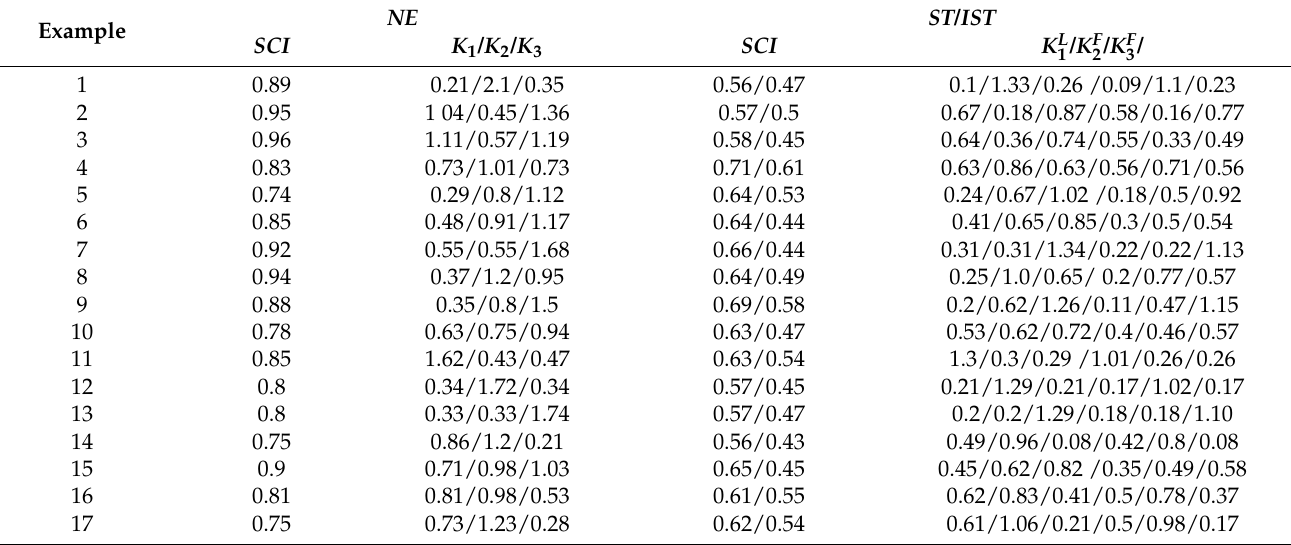
Table 10. Indices of relative efficiency of the players for different information structures with consid- eration of the green